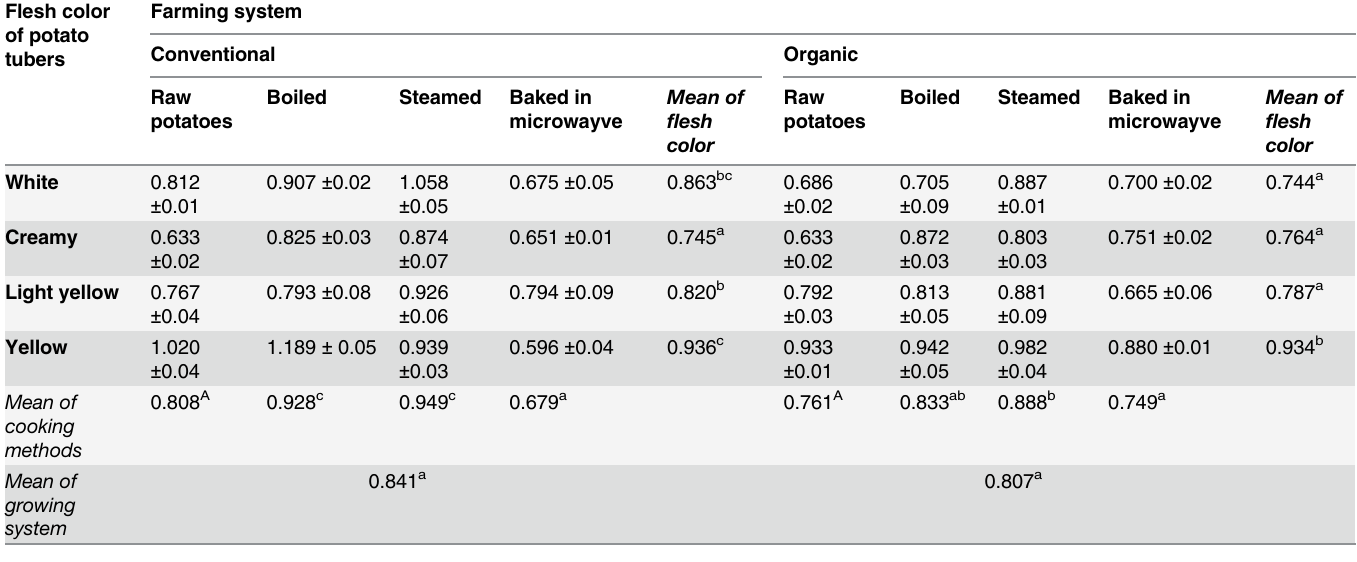
Table 3. Effect of different cooking methods and flesh color on ascorbic acid contents [AA mg (cid:3) g -1 DM] in potato tubers grown under organic and conventional systems.